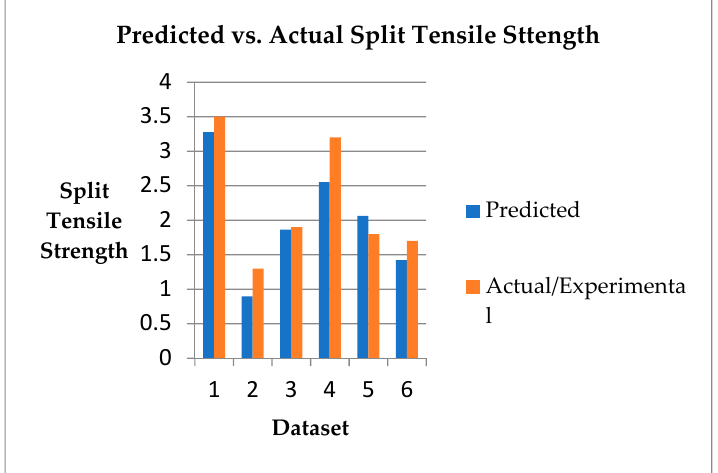
Figure 4. Graphical representation of experimental value (actual) and projected strength due to compression of fly-ash, calcined -clay-based geopolymer concrete.